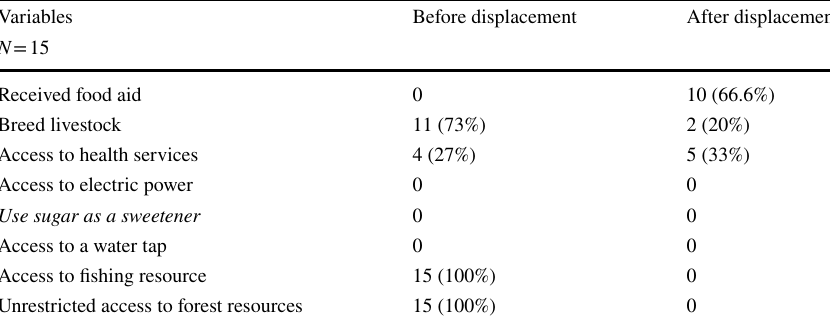
Table 5 The socio-economic situations of selected smallholder farmers before and after displacement Variables Before